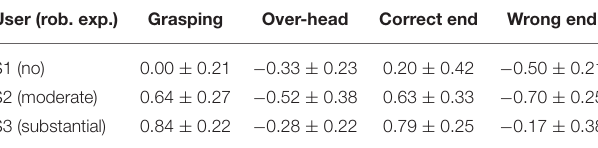
TABLE 1 | Mean ± std subjective ratings at key robot